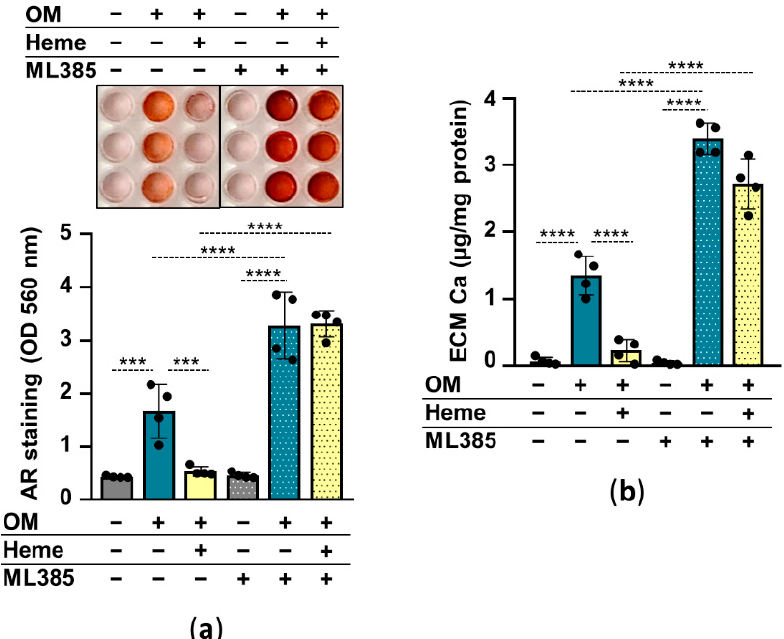
Figure 5. Inhibition of Nrf2 diminishes the anti-calcification effect of heme. ( a , b ) Confluent HuLECs (passages 5–8) were pretreated with vehicle or ML385 (10 µmol/L) for 3 h. After the pretreatments cells were maintained in Ctrl, OM, or OM + heme (10 µmol/L) conditions. ( a ) Representative AR staining and quantification from 4 independent experiments are shown (day5). ( b ) Ca content of the HCl-solubilized ECM is presented (day5). Data points are derived from 4 independent experiments. Data are expressed as mean ± SD. Ordinary one-way ANOVA followed by Tukey’s multiple comparison test was used to obtain p values. *** p < 0.005, **** p <